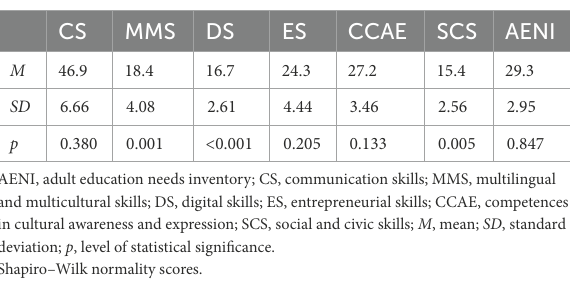
TABLE 5 Normality of distribution of the AENI ( N = 98).